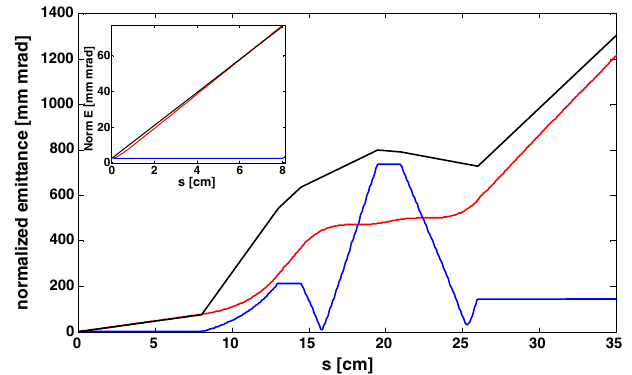
FIG. 2. Normalized transverse emittance along a transport line using magnetic quadrupoles: comparison between TSTEP simu- lations (red line), Eq. (4) (black line), and the (cid:6)" approximation (blue line). Inset: Zoom of the initial